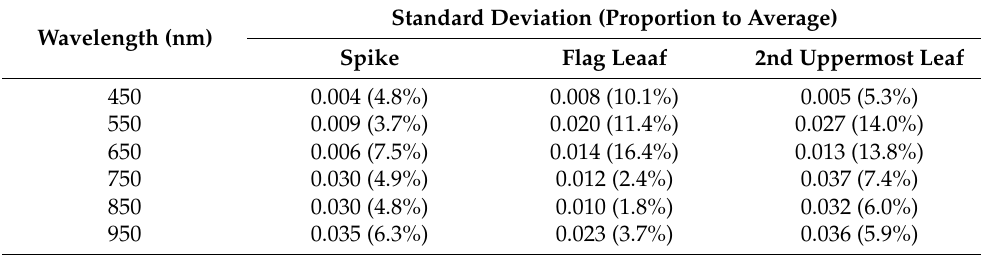
Table 1. Standard deviation of the reflectances measured in organs at different